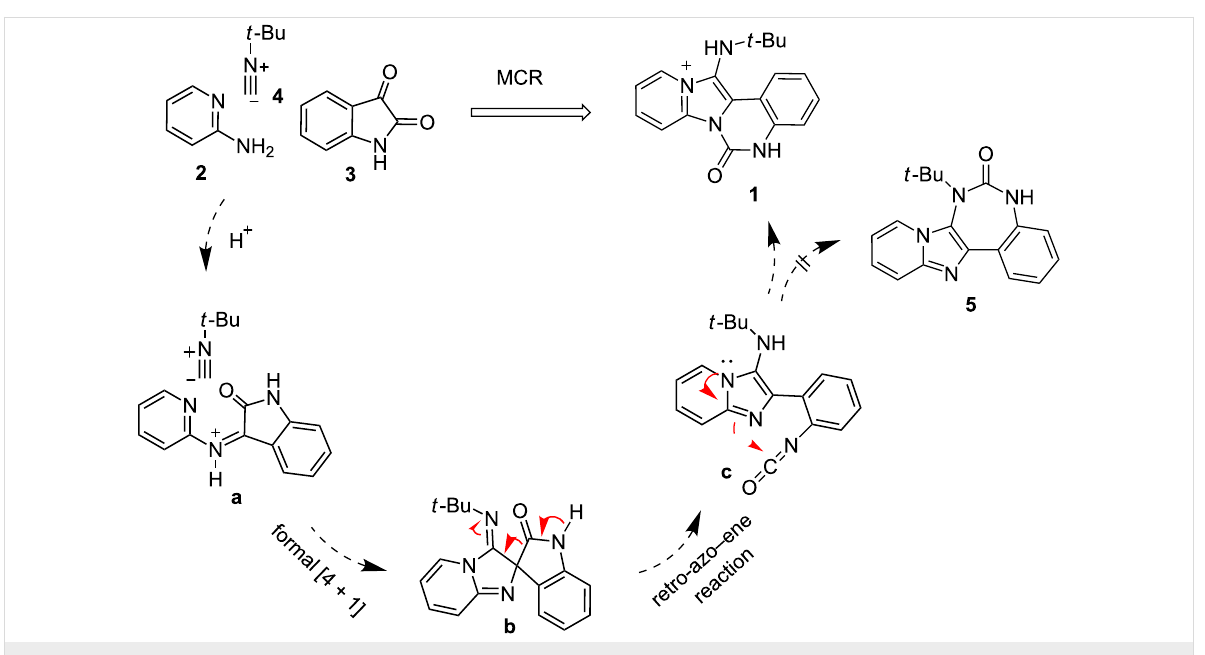
Figure 2: Mechanistic rationale for the MCR